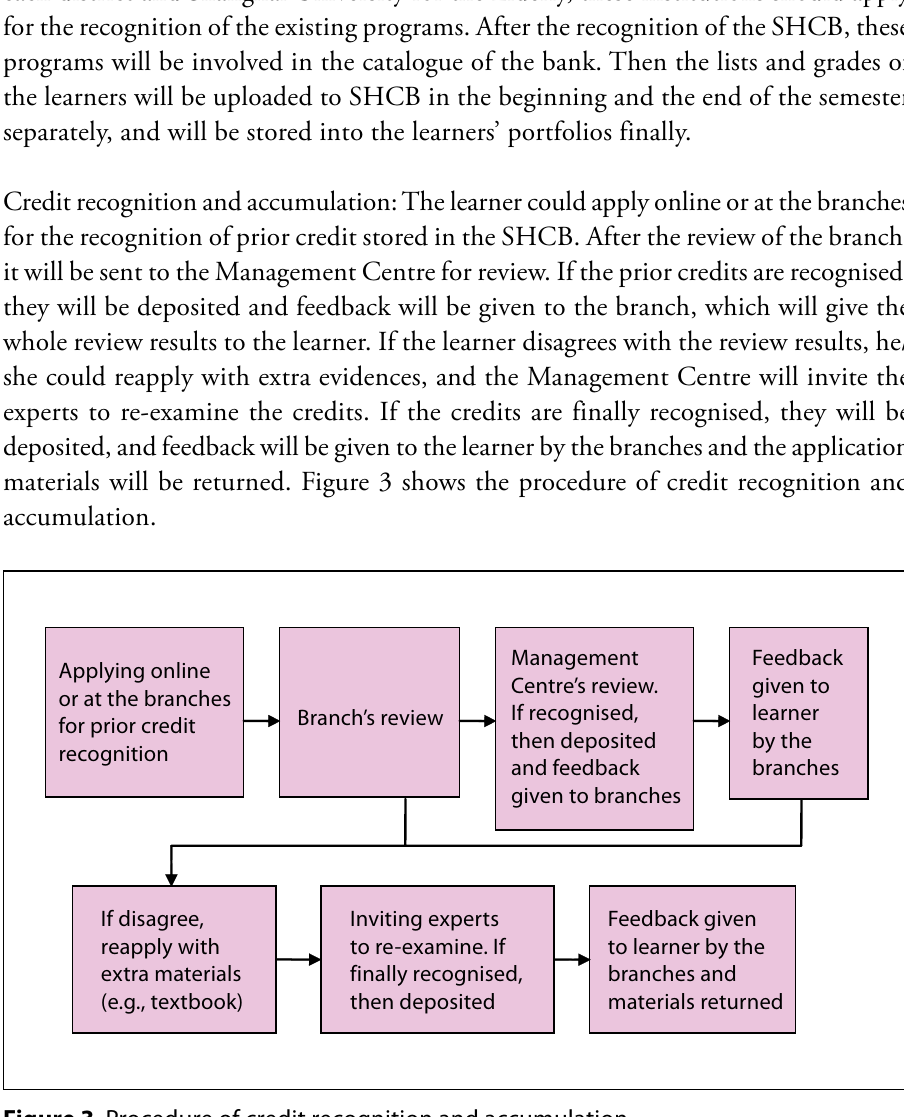
Figure 3 Procedure of credit recognition and